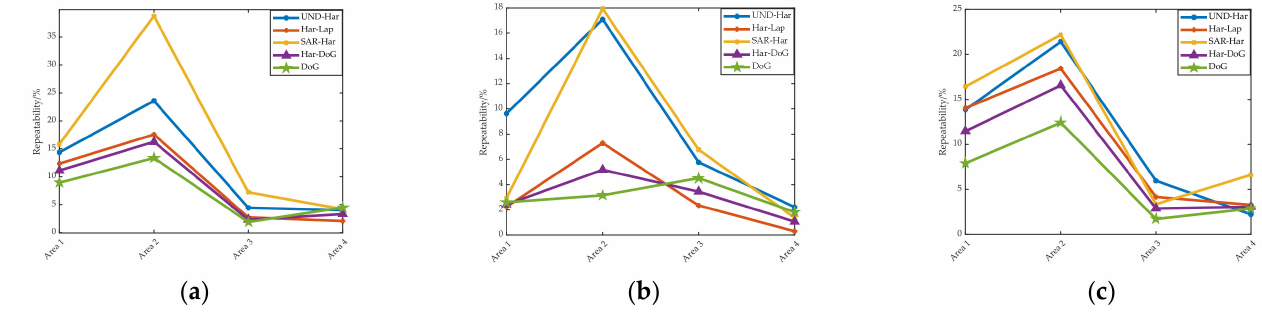
Figure 10. Influence of nonlinear intensity difference on repeatability: ( a ) Spaceborne SAR-to- Airborne SAR. ( b ) Optical-to-Airborne SAR. ( c ) Optical-to-Spaceborne SAR.